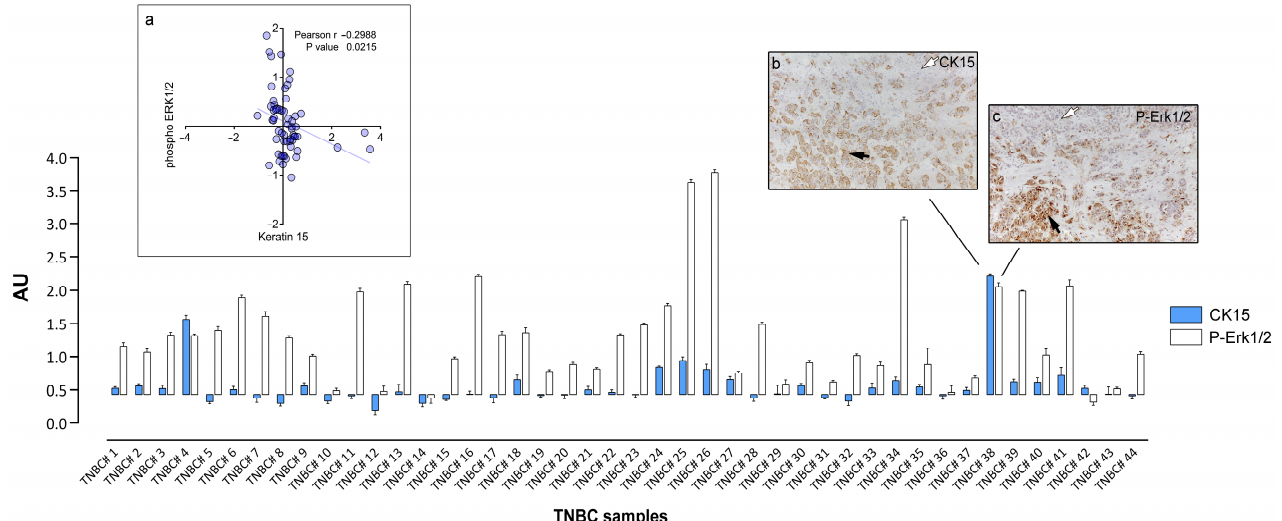
Figure 3. Expression of CK15 and Erk1/2 phosphorylation in TNBC samples determined by IHC. Normalized RPPA values for CK15 and P-Erk1/2 were plotted using as baseline value the threshold RFI value of samples found negative by IHC analysis (subpanel a ). IHC images of a heterogenous sample containing cancer cells positive (black arrow) and negative (white arrow) for CK15 (subpanel b ) or P-Erk1/2 (subpanel c ), respectively are presented for illustration purposes. Magnification, 20×.